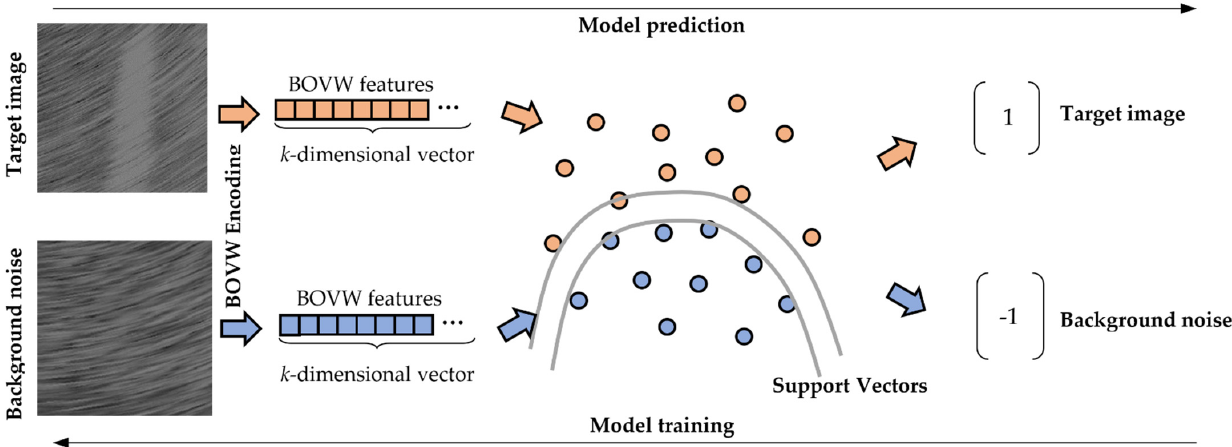
Figure 6. Procedure of SVM binary classification on BOVW features.